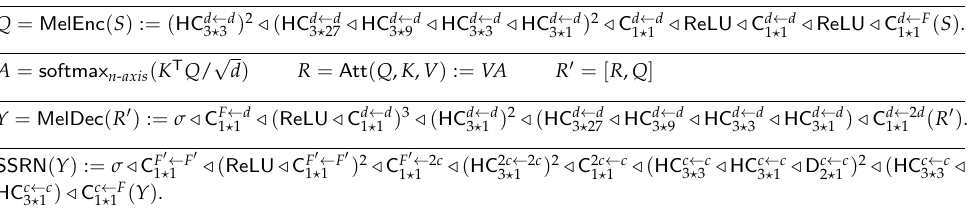
Figure 1. Details of DCTTS architecture [22].